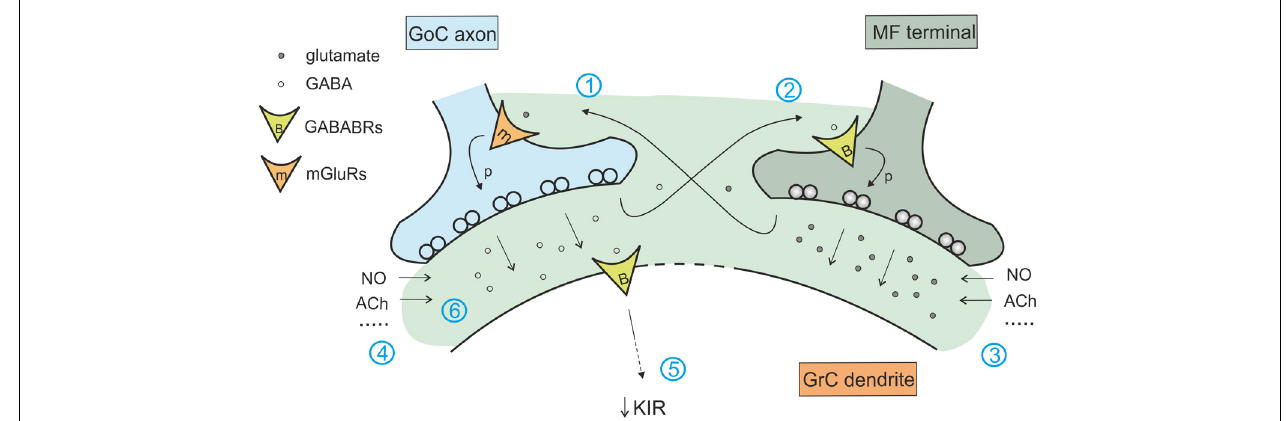
FIGURE 5 | Interaction of the excitatory and inhibitory mechanisms in the glomerulus. The cerebellar glomerulus allows the cross-talk of excitatory mossy fiber-granule cell connections and inhibitory Golgi cell-granule cells contacts. (1) glutamate spillover to Golgi cell pre-synaptic mGluRs determines a decrease in GABA release (Mitchell and Silver, 2000b). (2) GABA spillover activates pre-synaptic GABA-B receptors on mossy fiber terminals, causing a decrease in glutamate release (Mitchell and Silver, 2000a). (3) Various modulators of excitatory transmission affect inhibition through mechanism 1, regulating the amount of glutamate released (Maffei et al., 2003; Sola et al.,